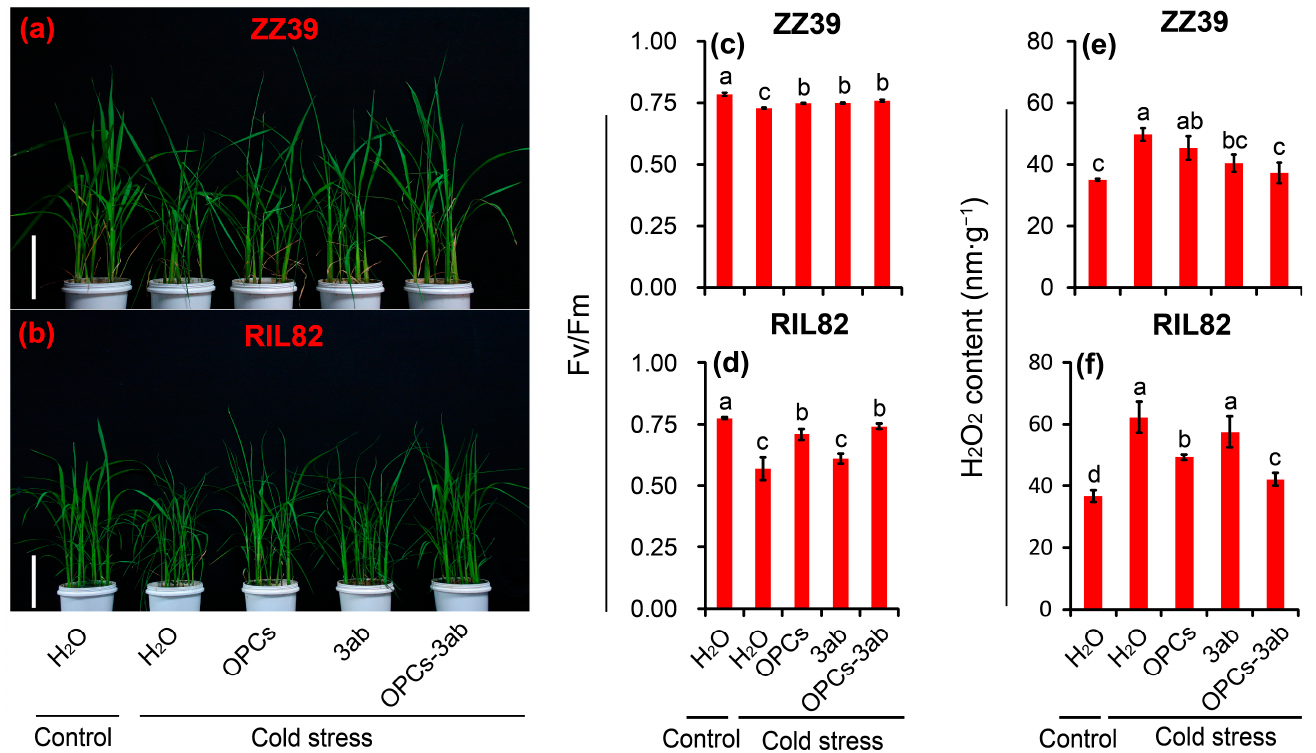
Figure 7. Effect of OPCs and 3-ab on leaf morphology, H 2 O 2 content, and Fv/Fm in rice leaves under cold stress. ( a , b ), leaf morphology; ( c , d ), Fv/Fm; ( e , f ), H 2 O 2 content. OPCs, oligomeric proanthocyanidins; 3-ab, 3-aminobenzamide; Fv/Fm, Maximum fluorescence quantum of PSII; H 2 O 2 , hydrogen peroxide. The reference scales of ( a , b ) represent 10 cm. Vertical bars denote standard deviations ( n = 3). Different letters indicate significant differences among the control and cold stress treatments within a genotype by two-way analysis of variance (temperature and treatment) ( p < 0.05).